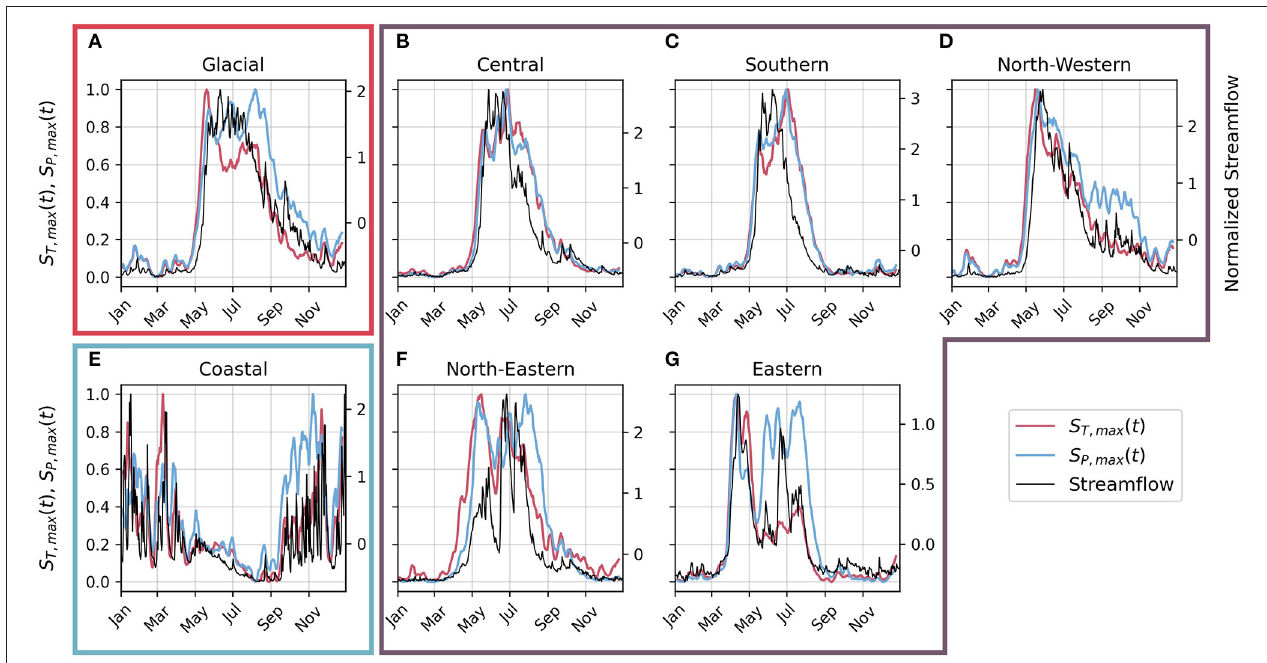
FIGURE 5 | The daily maximum sensitivity to temperature and precipitation perturbations ( S T ,max ( t ) and S P ,max ( t )) alongside observed streamflow for each of the stream gauge clusters. A single year in the testing dataset (2011) is shown as an example. The clusters belonging to the glacial (A) , nival (B,C,D,F,G) , and pluvial (E) regimes are indicated by the bounding